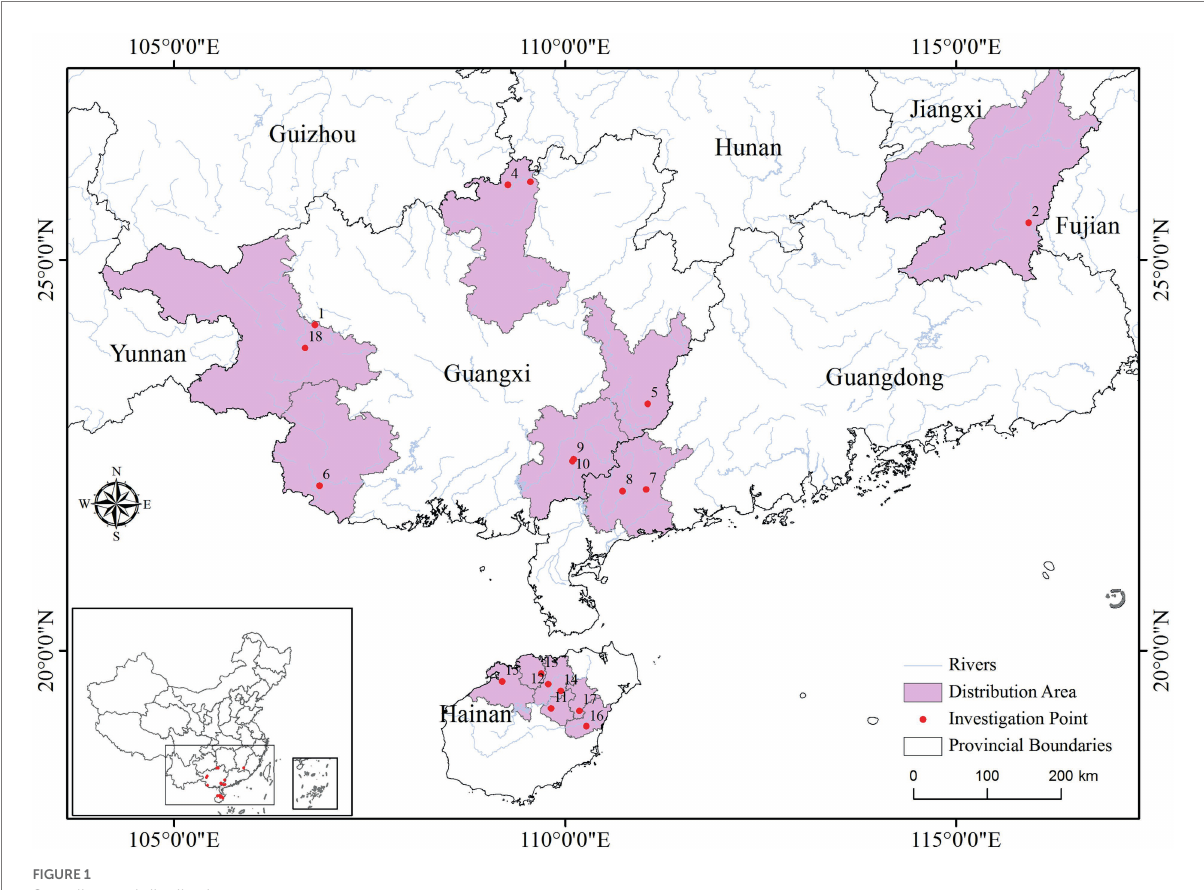
FIGURE 1 Sampling and